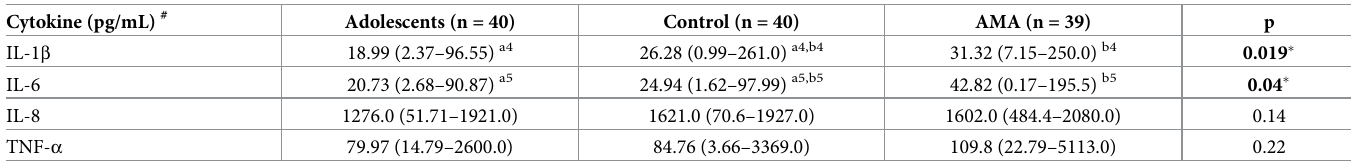
Table 4. Concentration of the evaluated cytokines in colostrum of adolescent, control and advanced maternal age nursing mothers included in the study. Cytokine (pg/mL)